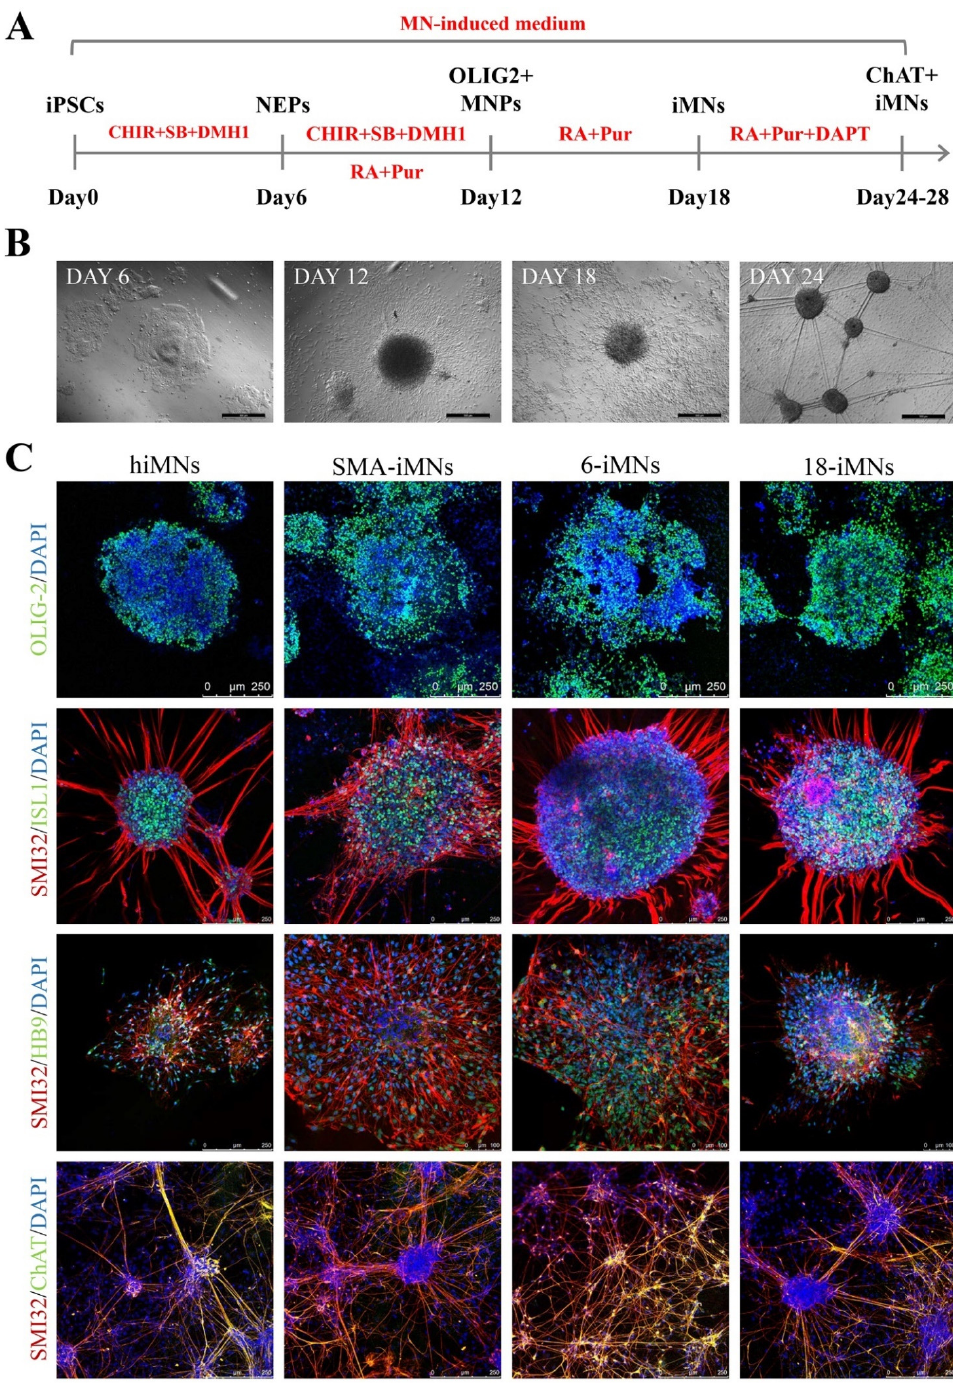
Figure 4. Differentiation of iPSCs into motor neurons. ( A ) Schematic protocol for motor neuron differentiation. NEPs, neuroepithelial progenitors; MNPs, motor neuron progenitors; iMNs, induced motor neurons; CHIR, CHIR99021; SB, SB431542; RA, retinal acid. ( B ) Dynamic changes in cellular morphology during differentiation of iPSC-derived MNs (iMNs). Scale bar: 500 µ m. ( C ) Immunos- taining of MNPs markers OLIG-2 at day 12 and motor neuron markers (ISL1, SMI32, HB9 at day 18, and ChAT, SMI32 at day 24). DAPI was used for nuclear staining. ISL1,